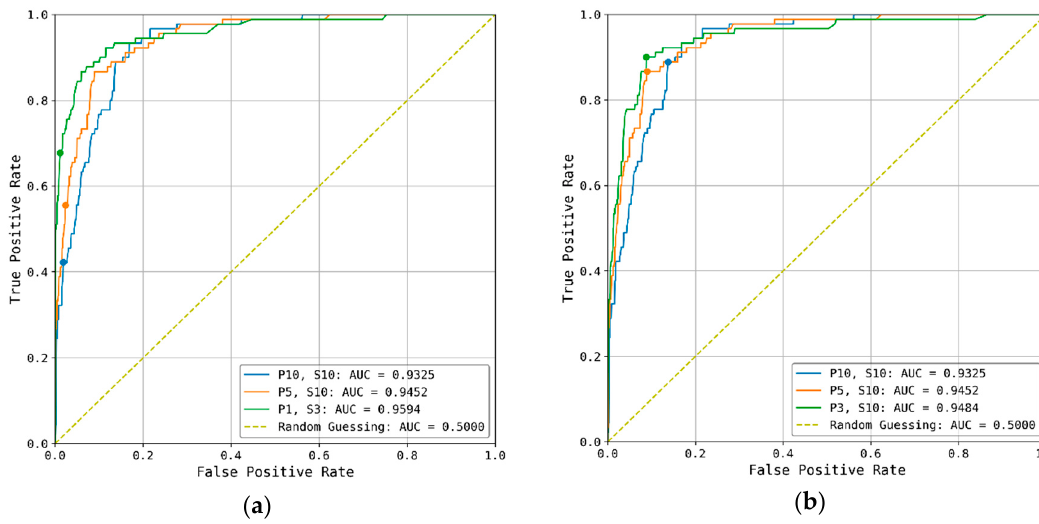
Figure 7. City of Portland ROC curves showing the performance of different threshold formats optimized with: ( a ) threat score; ( b ) optimal point statistic. Optimal thresholds for each curve are shown as the solid dots. Recent rainfall and saturation for N days shown as P N and S N , respectively.